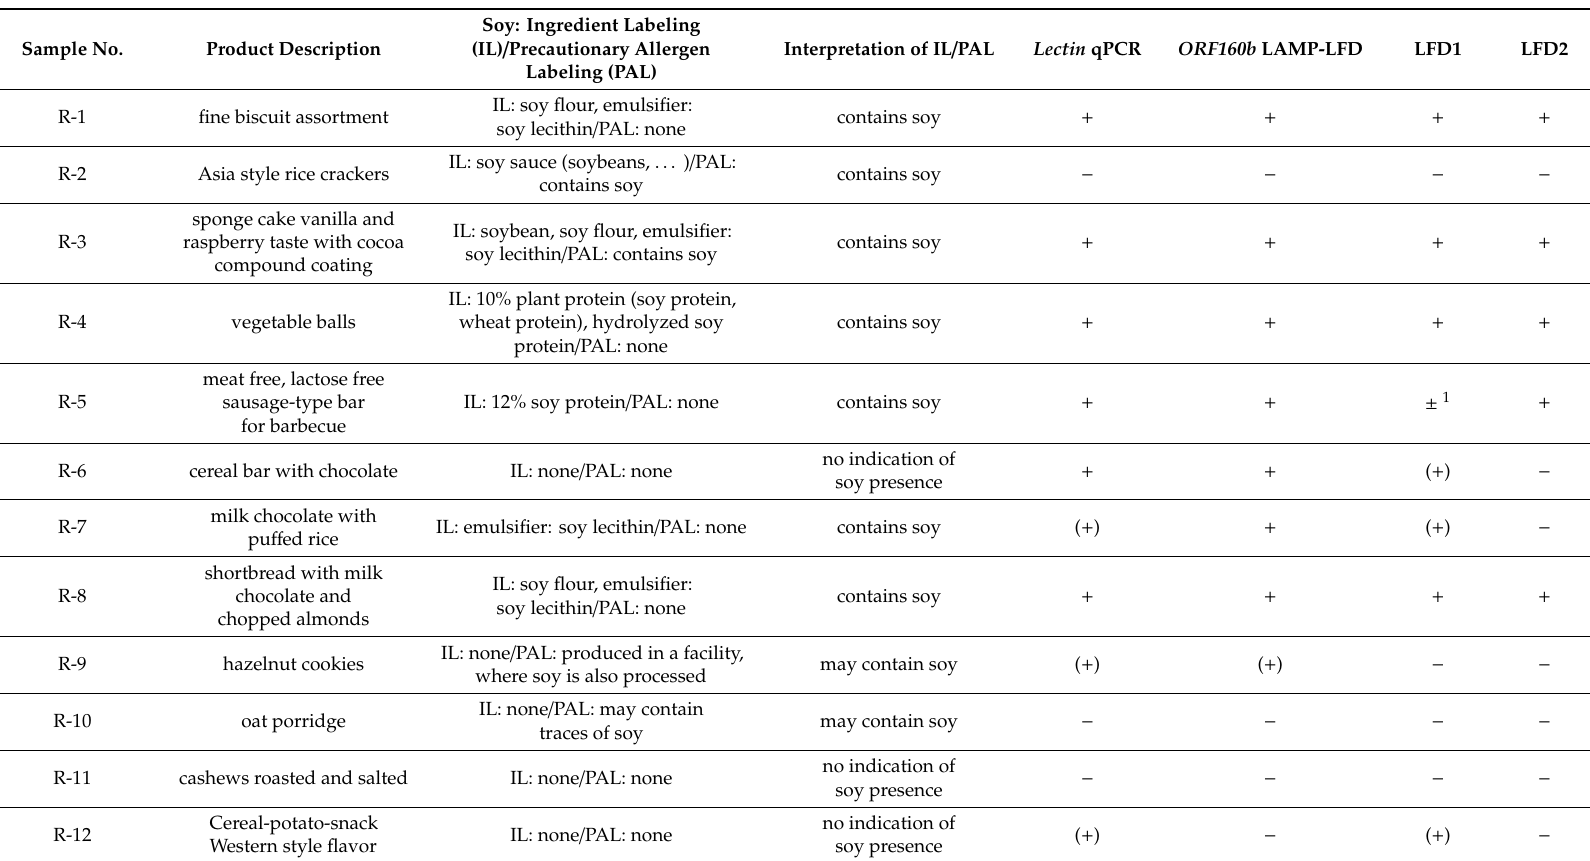
Table 4. Analysis of retail foods (R) for soybean using ORF160b LAMP-LFD and two commercially available protein-based LFDs. The lectin qPCR served as a comparative DNA-based detection method ( + : all replicates tested positive; − : all replicates tested negative; ( + ): not all replicates of LAMP / qPCR tested positive, or faint test line in commercial